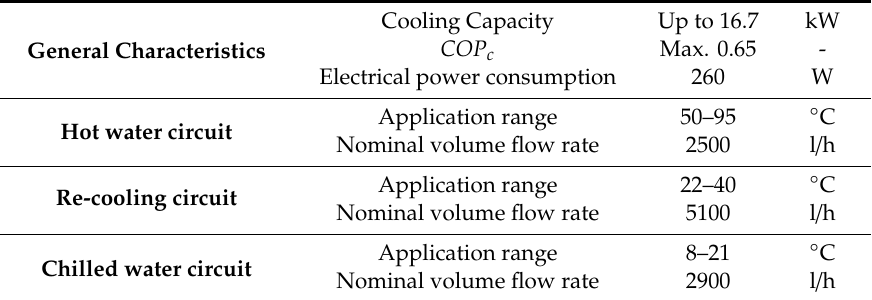
Table 2. Characteristics of the Fahrenheit eCoo 10 machine tested on the test